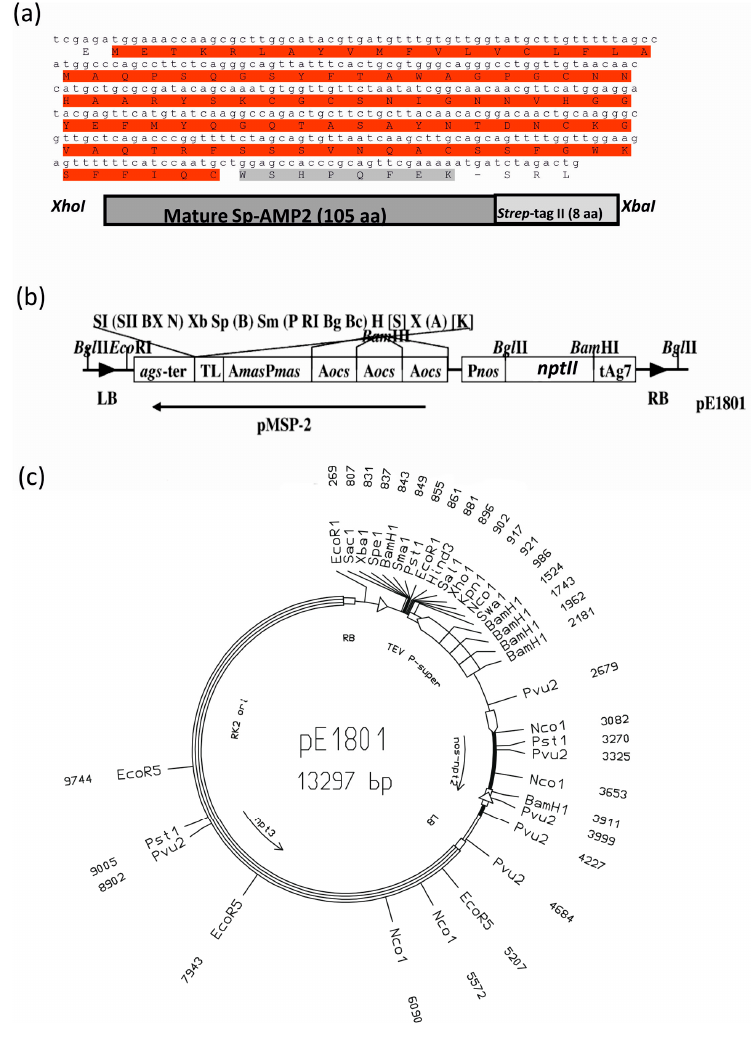
Figure 1. Sequences of the amino acids and the nucleotides of the signal peptide of Sp ‐ AMP2. ( a ) Red shadowed amino acids show the peptide sequence of Sp ‐ AMP2 protein, grey shadowed amino acids show the Strep ‐ tag II. ( b ) Map of the T ‐ DNA binary vector pE1801. Cassette, pMSP ‐ 2 , with the Translational (TL) enhancers element from Tobacco Etch Virus (TEV); P nos , nos promoter; tAg7 , poly (A) addition signal for T ‐ DNA gene 7; nptII , gene conferring resistance to kanamycin; A ocs , ocs transcriptional activating element; A mas P mas , mas2 ′ activating and promoter elements; ags ‐ ter, poly (A) addition signal from the agropine synthase gene, LB and RB, left and right border sequences delimiting T ‐ DNA. Restriction endonuclease sites within parentheses are not unique to the plasmid. ( c ) Original pE1801 map before modification ( Nco I site was deleted) which shows restriction sites relevant for